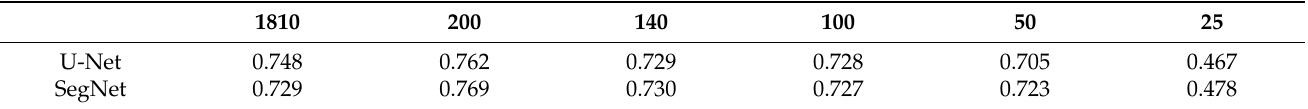
Table 3. Results (Average IoU) with only leading frames of thermal sequence on the validation dataset. The original measurement contains 1810